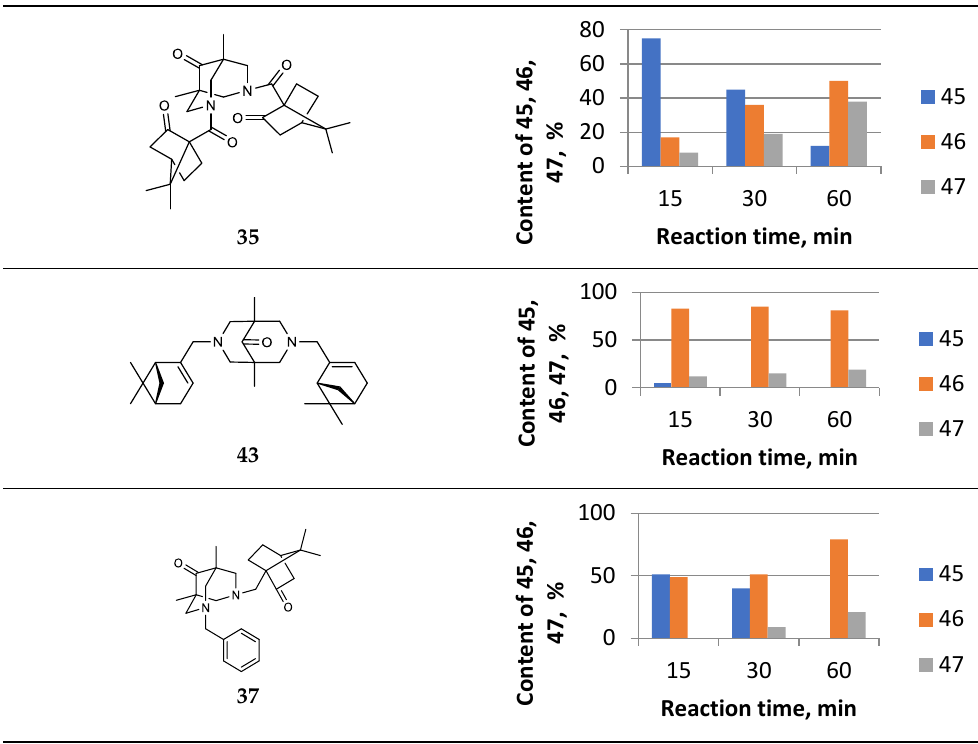
Table 5. Content of compounds 45 , 46 and 47 in reaction mixtures after 15, 30 and 60 min from the start of the reaction.